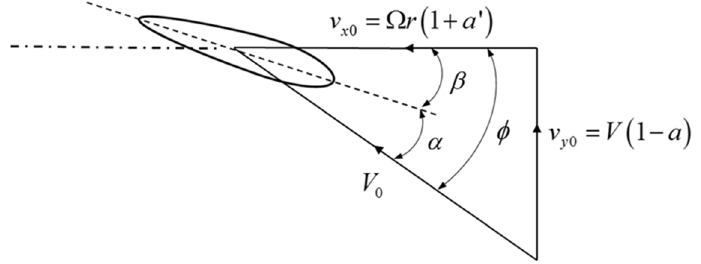
Figure 1. Diagram of blade element.